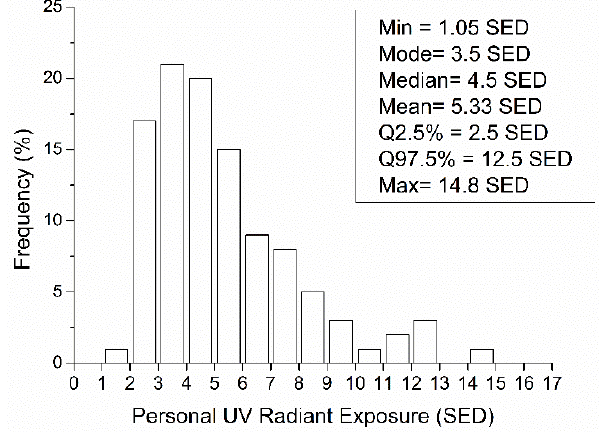
Figure 2. Example of the typical frequency distribution of PE like that found by Larkö and Diffey [29] and others. Indicated are the appropriate statistical descriptors: minimum (Min), 2.5%-percentile (Q2.5%), mode, median, mean, 97.5%-percentile (Q97.5%) and maximum (Max). The percentiles indicate the 95% confidence interval. The distribution has right skewness as mode, median and mean differ as well as the distances between the mean and Q2.5% respectively Q97.5% do (data are taken from [27]).